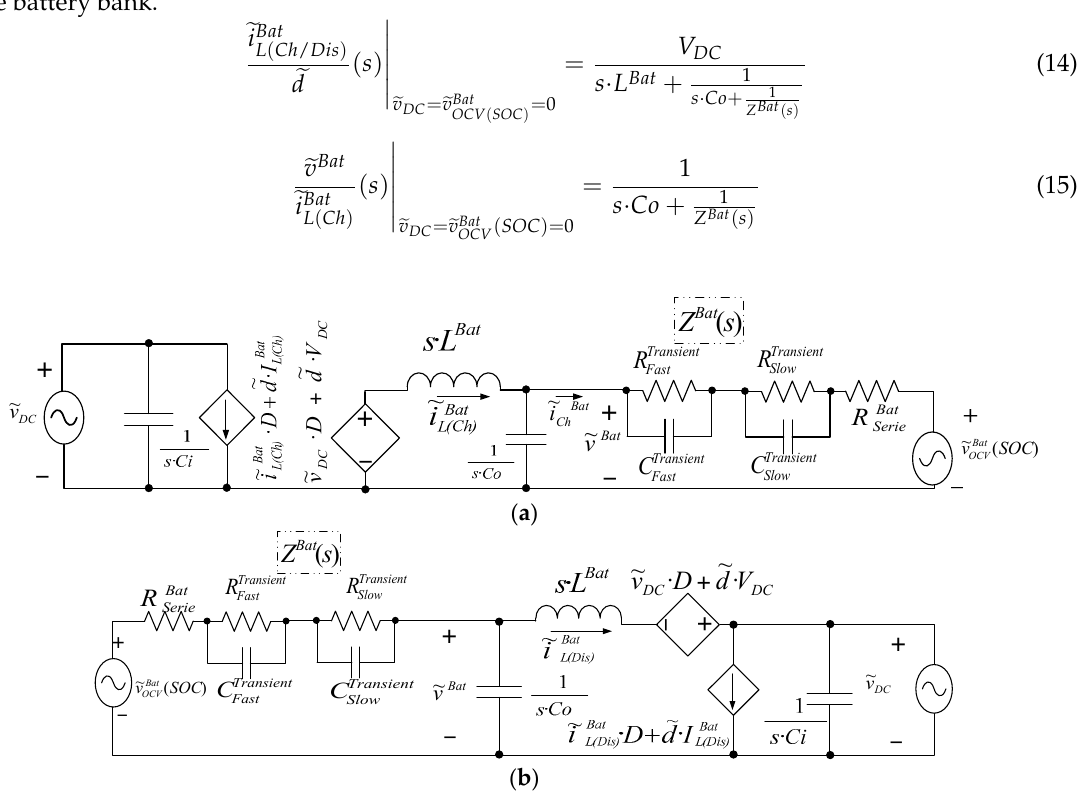
Figure 4. Small-signal model of the half-bridge DC/DC converter: ( a ) Buck small-signal model, charge mode (Ch); ( b ) Boost small-signal model, discharge mode (Dis).